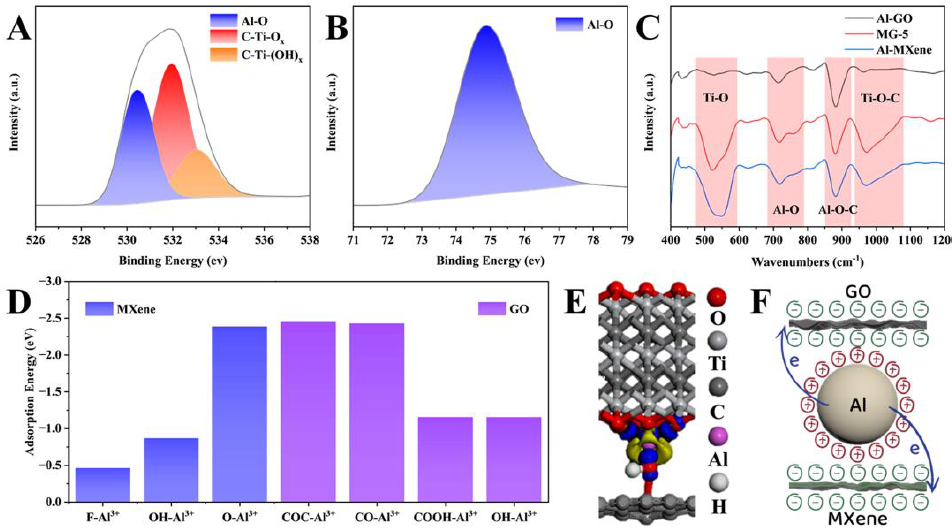
Figure 2. Cross-linking mechanism of MG. XPS of O 1s ( A ), Al 2p ( B ), and ( C ) FT − IR. ( D ) Adsorption energy. ( E ) Differential charge density maps. The blue and yellow areas represent the electron accumulation and depletion, respectively. ( F ) The formation process of MG.